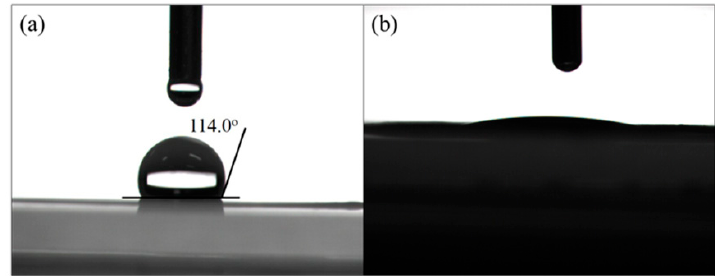
Figure 5. Water contact angles of ( a ) blank separator and ( b ) CNTs-coated separator.